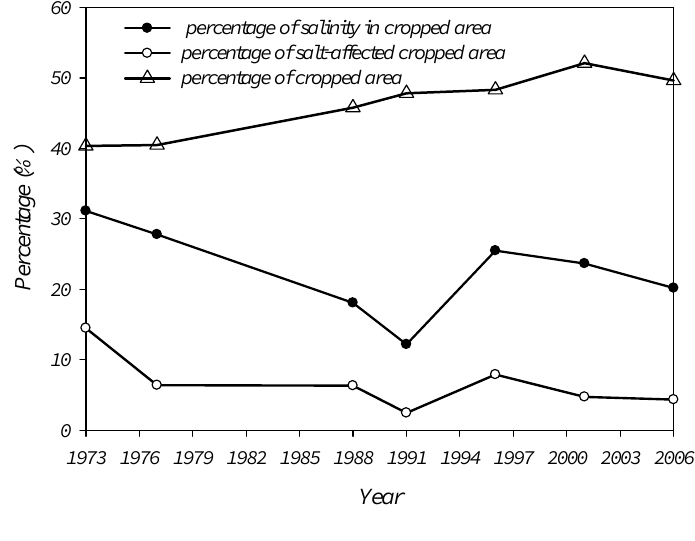
Figure 8. The percentages of cropped area, salinity in cropped areas and salt-affected cropped